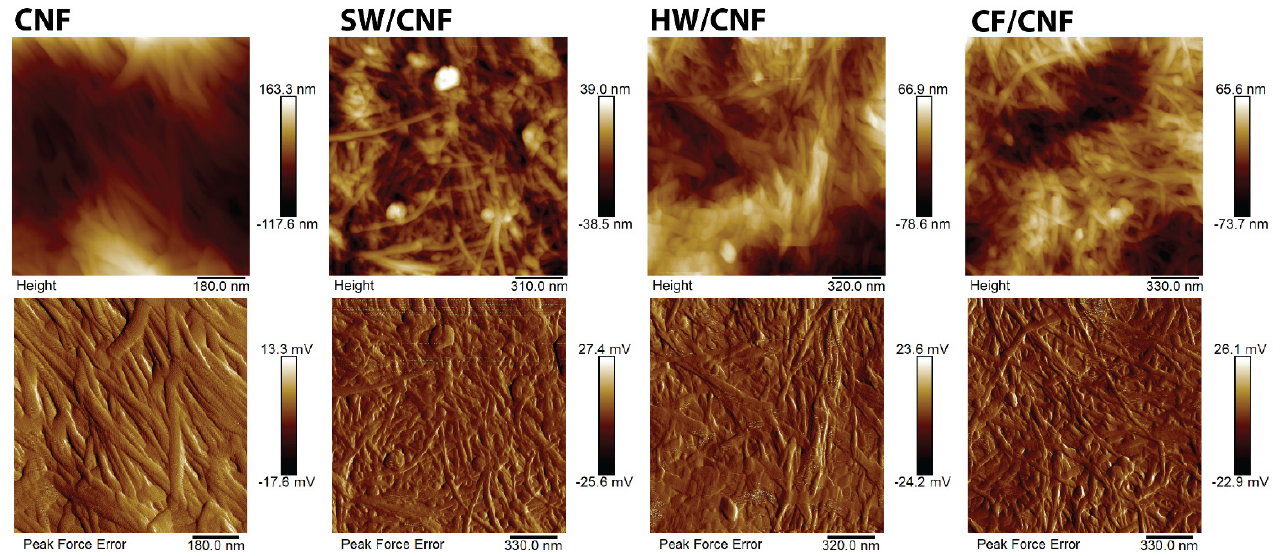
Figure 4. AFM images of the surface of composite lignocellulose membranes: height sensor (top row) and peak force error (bottom row) images.